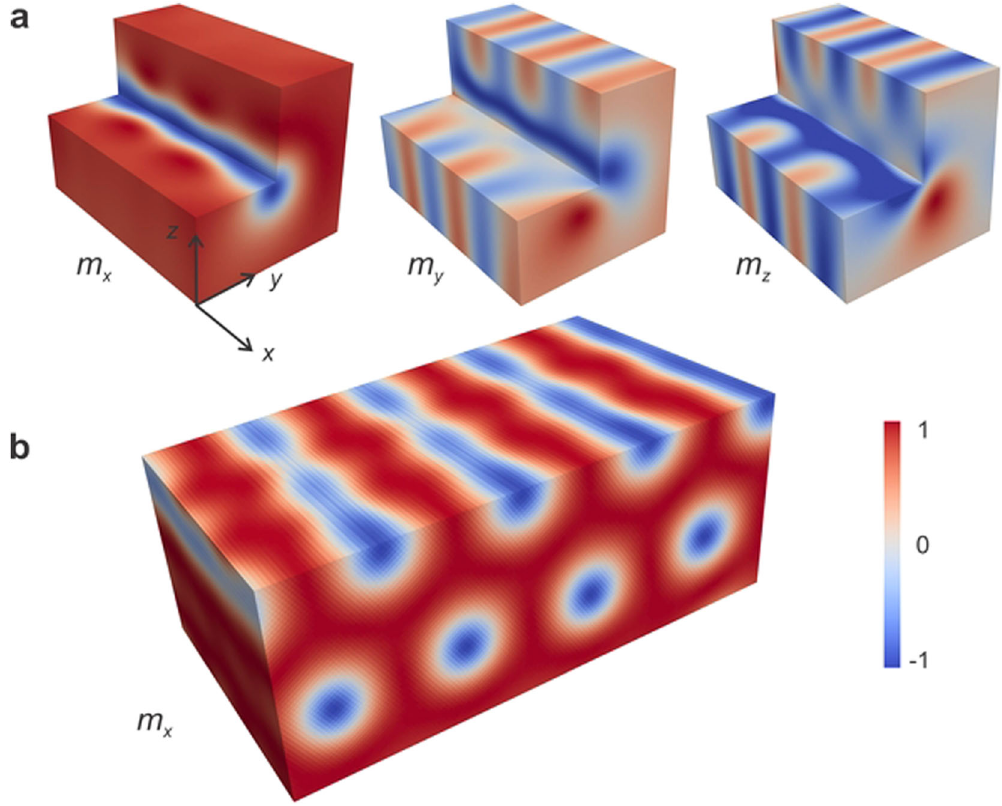
Fig. 5 Modulated skyrmion state. a Visualization of a single skyrmion string embedded in the conical state (from left to right, m x -, m y -, and m z -component of the magnetization). The core of the skyrmion is modulated periodically, with a period exactly matching that of the conical state. b Illustration of the conically modulated skyrmion lattice